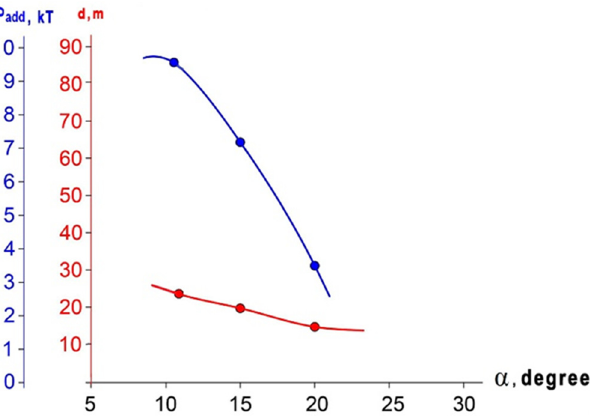
Figure 4. Dependence of the inclination angle of the break-down chamber on the distance to the permanent mine working and additional extraction from the extraction column area which is subject to robbing.